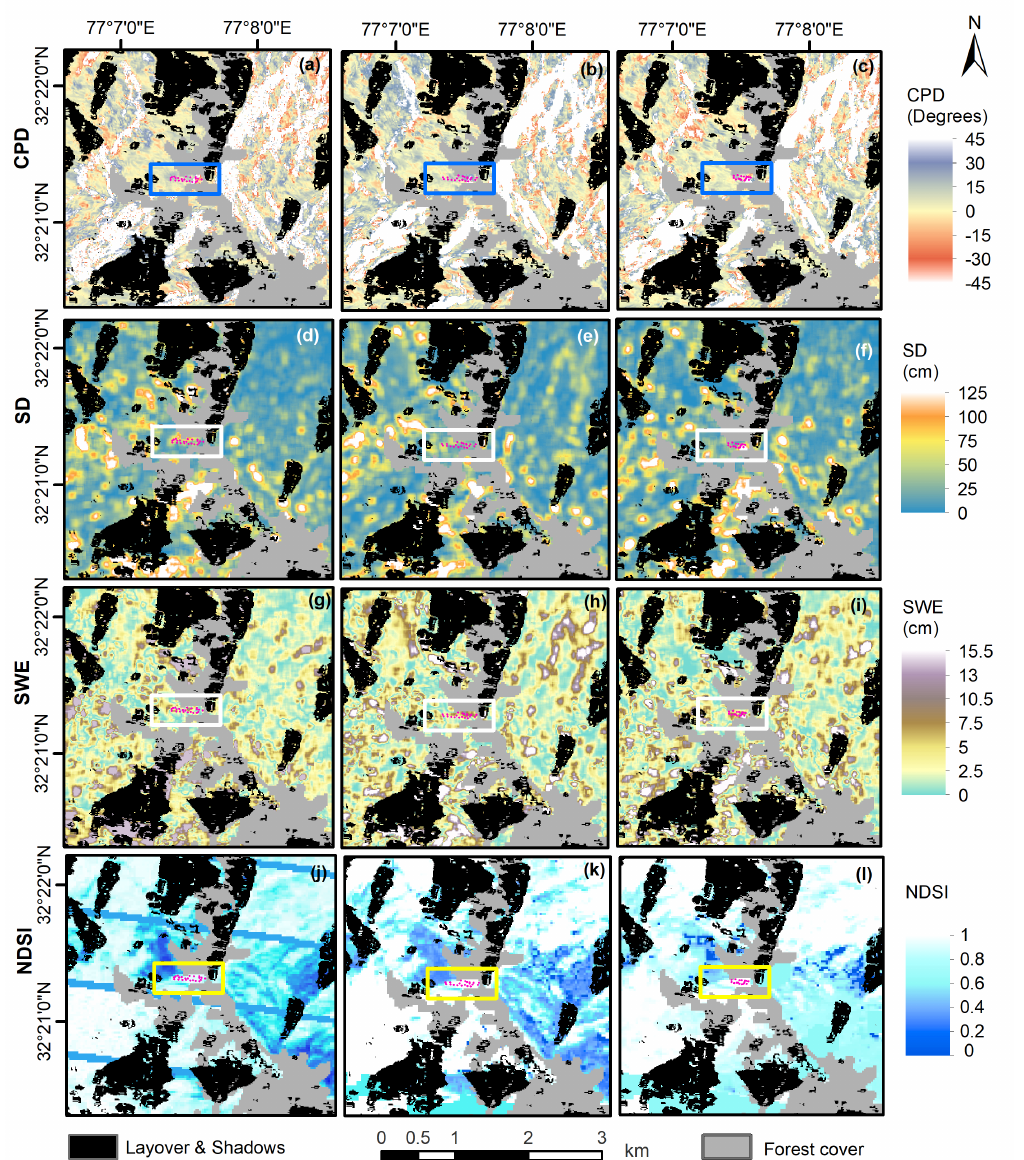
Figure 5. Co-polar phase difference (CPD ( a – c )), snow depth (SD ( d – f )), snow water equivalent (SWE ( g – i )), and normalized difference snow index (NDSI ( j – l )) over Dhundi observatory retrieved using the proposed algorithm for: 8 January 2016 (first column), 19 January 2016 (second column), and 30 January 2016 (third column). Forest mask was generated using ALOS data, NDSI was retrieved using Landsat -8 data, and layover shadow mask was generated using 12 meter ALOS digital elevation model. The location of Dhundi observatory is highlighted by blue (first row), white (second and third row), and yellow (fourth row) polygons. The magenta dots represents the location of validation